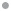
Comparison of the neutralizing capacity of the antivenoms manufactured by INS-COL (A-C), PROBIOL (D-F), ICP (G-I) towards the coagulant effect caused by the venoms of B. asper (sensu stricto) (●), B. rhombeatus (●), B. ayerbei (○). Clotting time was recorded after mixing and incubating 2 MCD (challenge dose) with different ratios of antivenom, as indicated in the figure, and adding them to human citrated plasma. Each point represents the mean ± SD of replicates of two independent experiments.